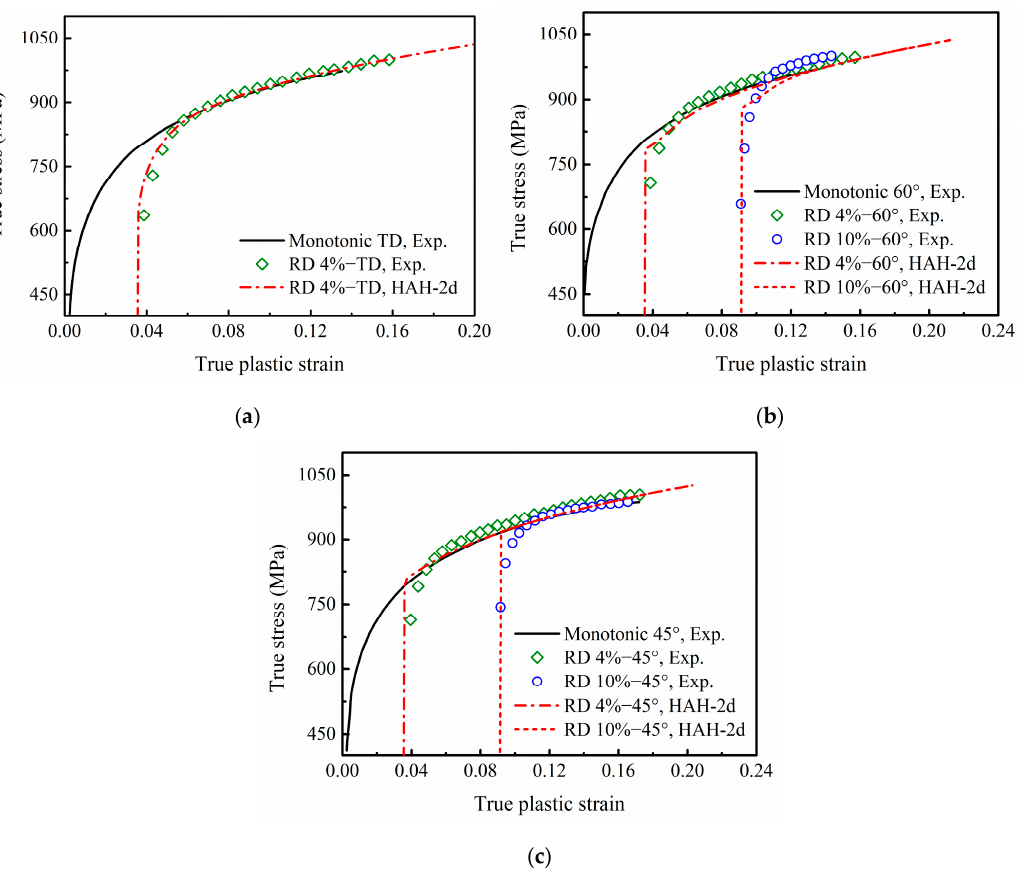
Figure 16. Experimental and predicted stress–strain curves of re-tension at ( a ) 90 ◦ , ( b ) 60 ◦ and ( c ) 45 ◦ from RD with 4% or 10% uniaxial pre-strain in RD for DP780. The experimental data are derived